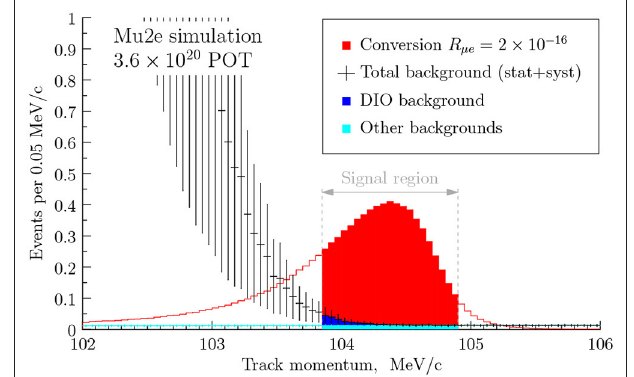
FIGURE 17 | The Mu2e CRV system, showing the neutron rates over the counters. From Bartoszek et al. [8].